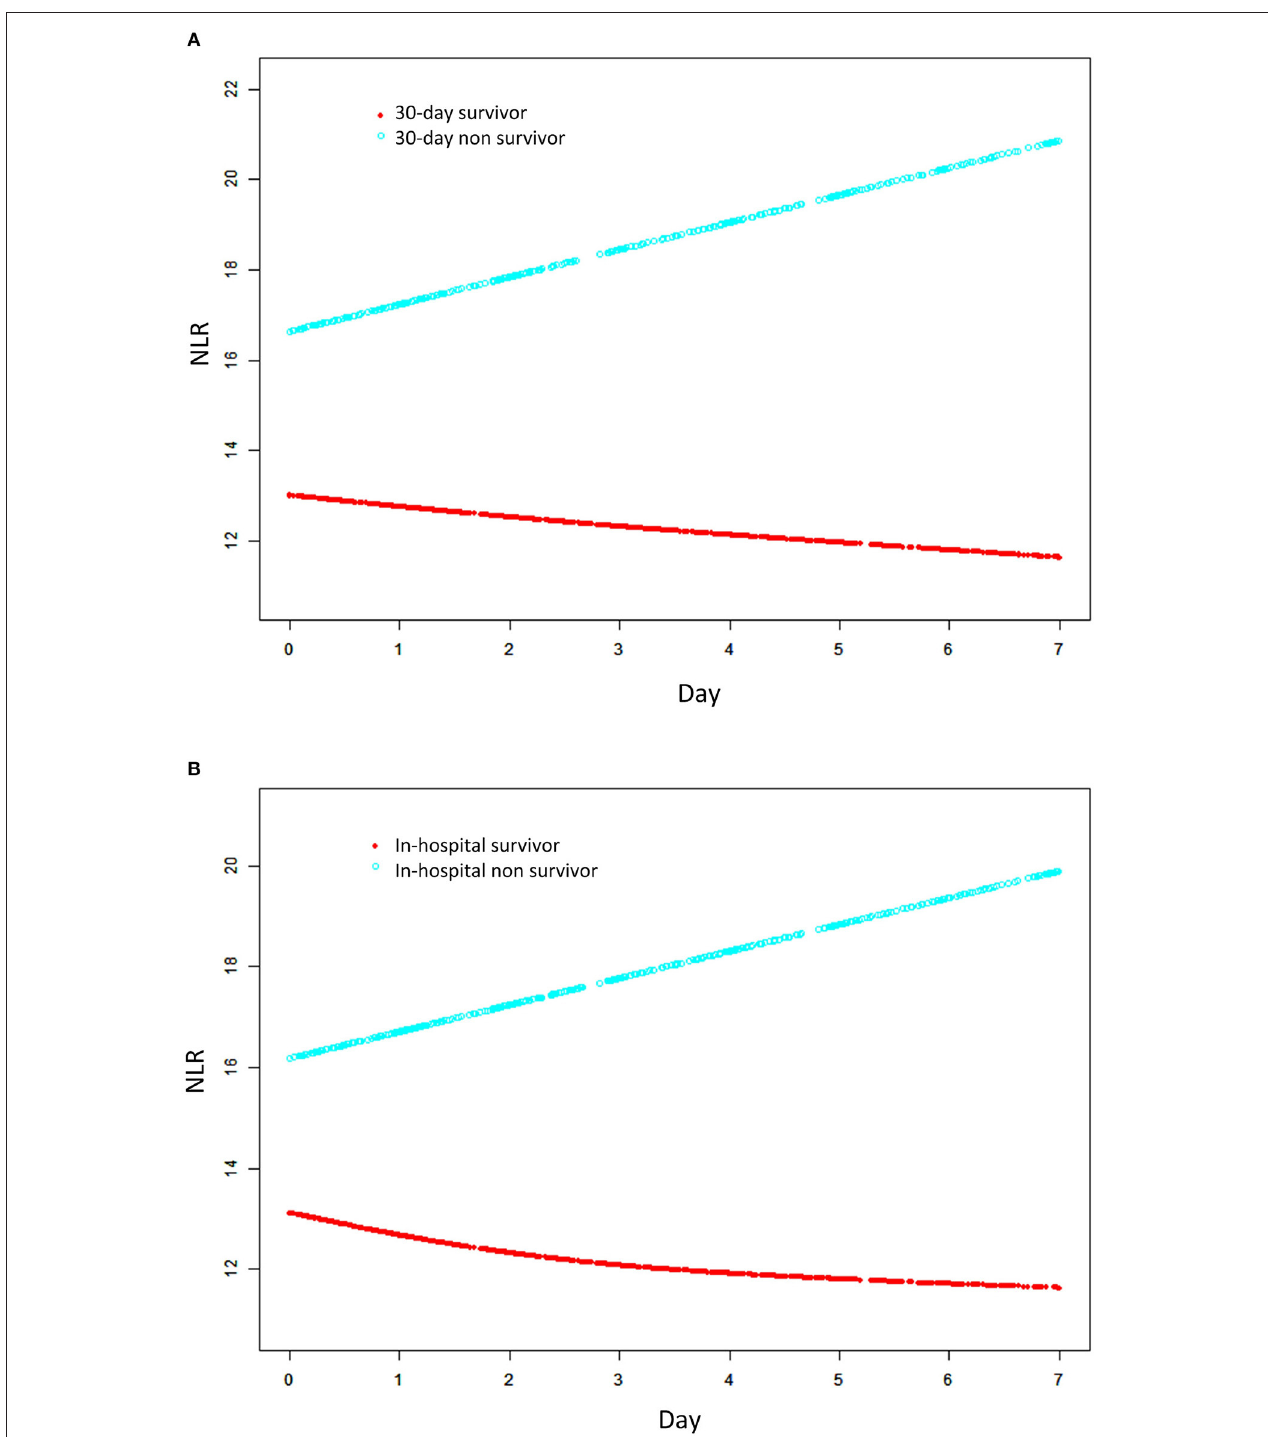
FIGURE 3 | Association between changes in NRL and 30-day mortality (A) and in-hospital mortality (B) . A linear association between changes in NLR and mortality was found in a generalized additive mix model (GAMM). Smooth curve fitting graph illustrated the NLR in 1164 ARDS patients based on the days after admission to ICU. The red line represented the survivors. The blue line represented the non-survivors. All adjusted for age, gender, ethnicity, smoking, admission type, COPD, hypertension, tumor, diabetes mellitus, renal failure, SID30, pneumonia, sepsis, aspiration, trauma/surgery, other non-pulmonary, PaO 2 /FiO 2 , SAPS II, OASIS, SOFA, corticosteroids therapy, antibiotic therapy, vasopressor therapy, ventilation received, and renal replacement therapy.